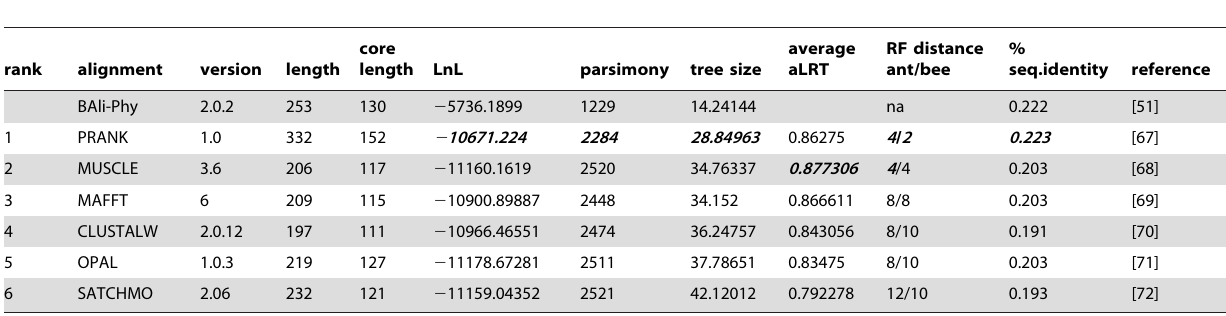
Table 2. Details of the multiple sequence alignment (MSA) methods used and maximum likelihood phylogenies estimated from